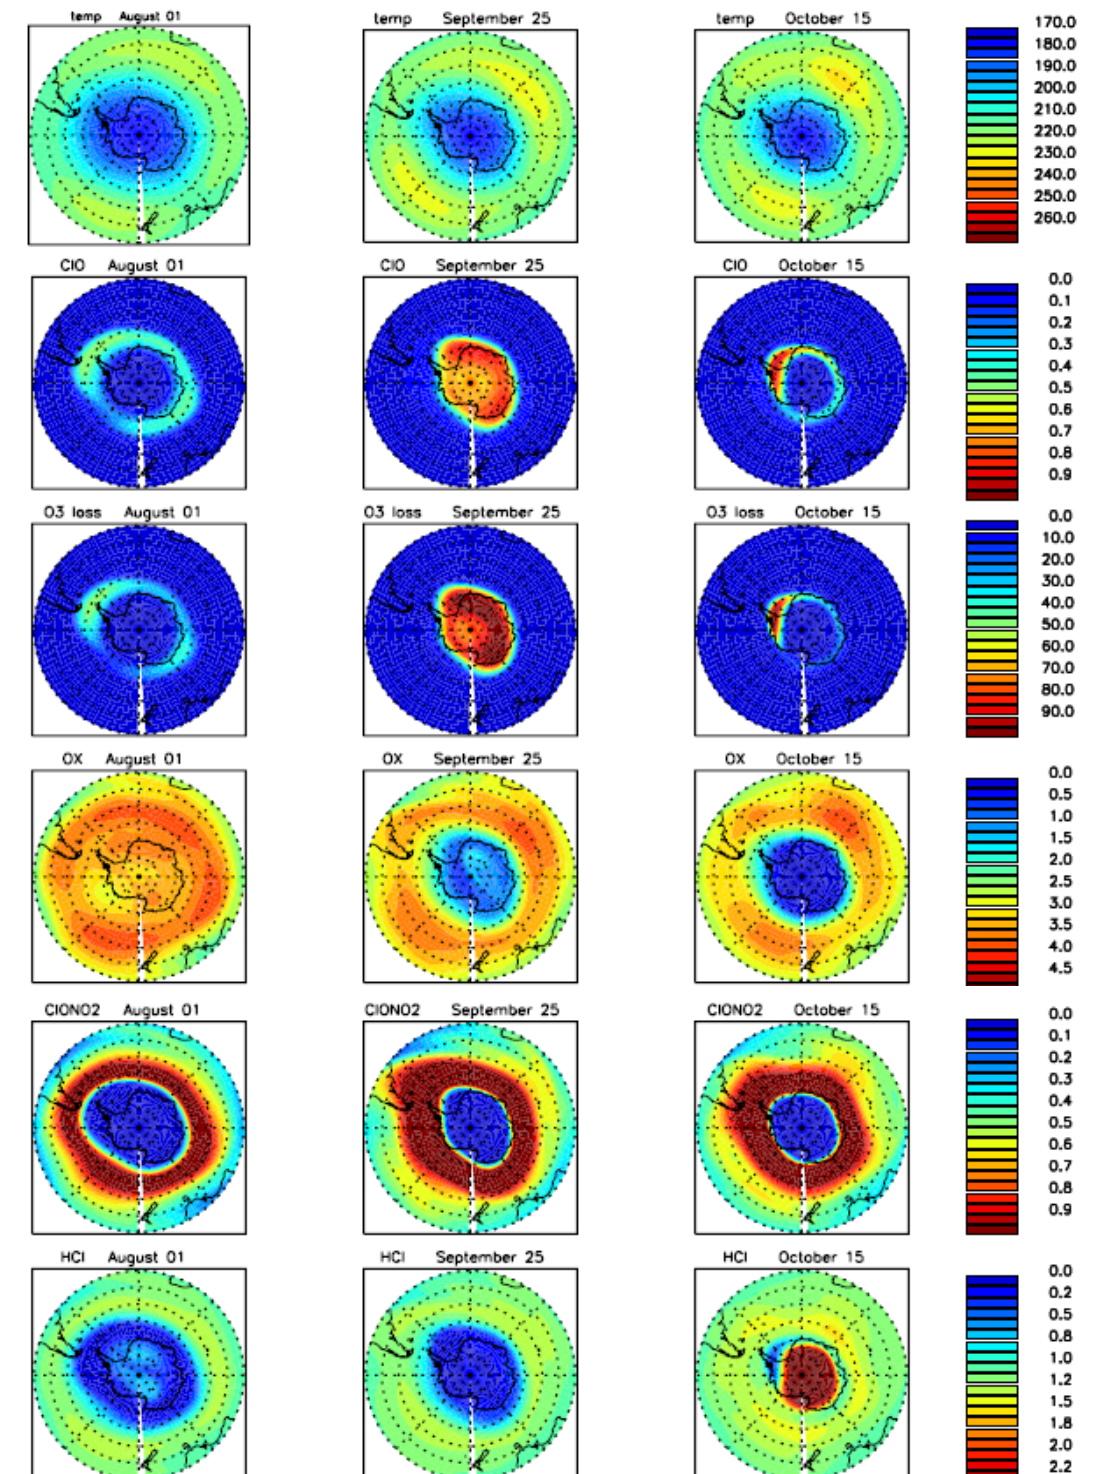
Fig. 14. Distribution of the temperature (K), ClO (ppbv), chemical loss rate of ozone (ppbv/day), O 3 (ppmv), ClONO2 (ppbv), HCl (ppbv) over Antarctic at 50hPa between late winter and early spring (1 August, 25 September, and 15 October) for the year corresponding to the Figure 14 : Distribution of the temperature (K), ClO (ppbv), chemical loss rate of 3 1993 ozone (ppbv/day), O3 (ppmv), ClONO2 (ppbv), HCl (ppbv) over Antarctic at 50 hPa 4 between late winter and early spring ( August 1, September 25, and October 15 ) for 5 the year corresponding to the 1993 forcing. 6